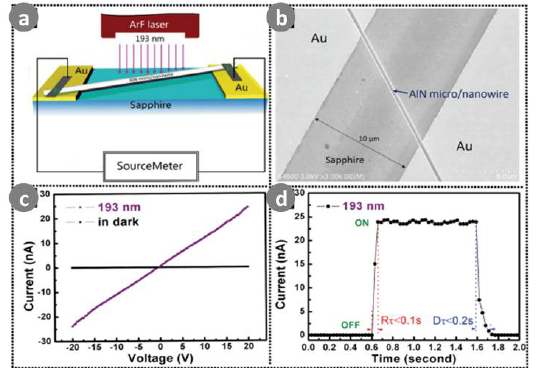
Table 1. The properties of SiC polytypes. Figure 13. ( a ) Schematic presentation and; ( b ) representative SEM image of as-prepared AlN micro/nanowire-based photodetector; ( c ) I – V characteristicsof AlN micro/nanowire-based